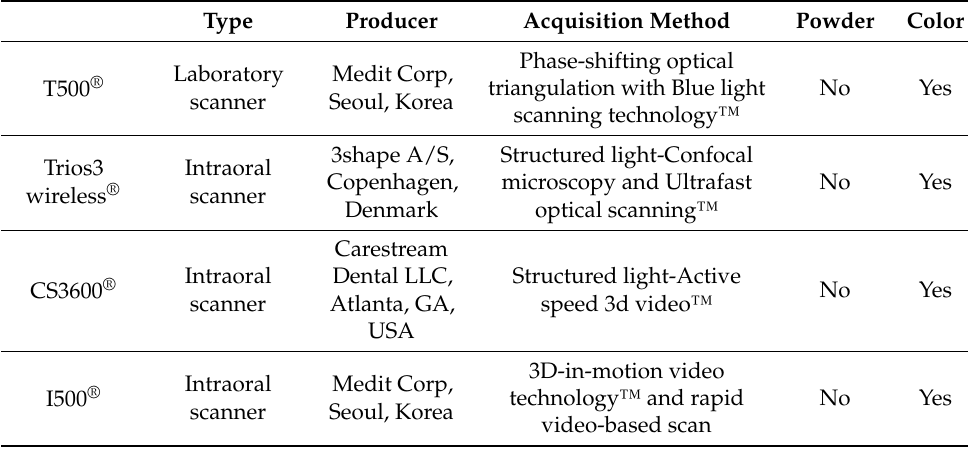
Table 1. Various scanners used in this